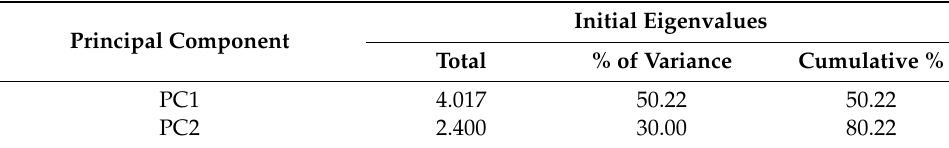
Table 3. Eigenvalues of each principal component.